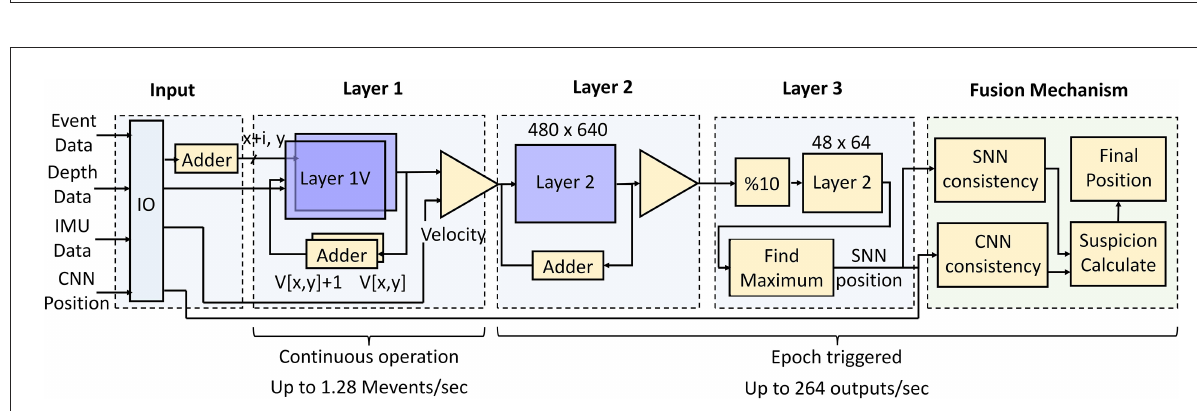
FIGURE12 FPGA micro-architecture for throughput controlling event pipeline and fusion algorithm. The execution of layers 2, 3 and the fusion algorithm determines the maximum potential throughput of 264 outputs per second. The asynchronous layer-1 has the capacity of handling 1.28 × 10 6 events per